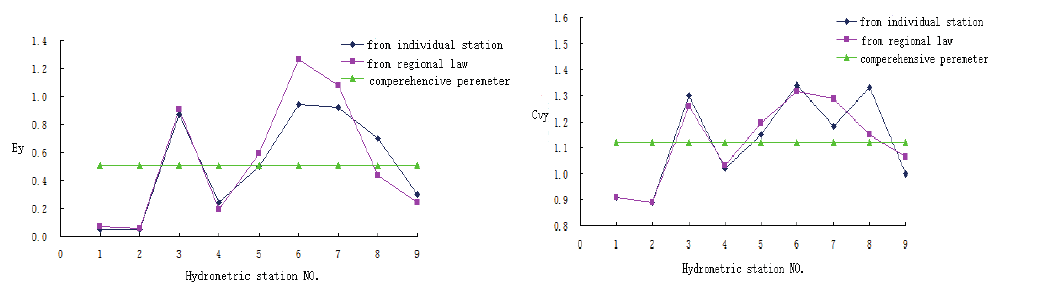
Fig. 3 Comparison of Ey , and Cvy at nine stations generated by different methods.